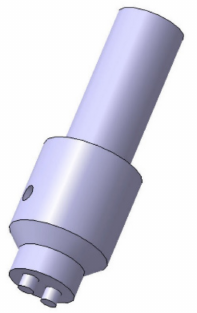
Figure 3. Model representation of the tools shown on the example of a two-pin tool.